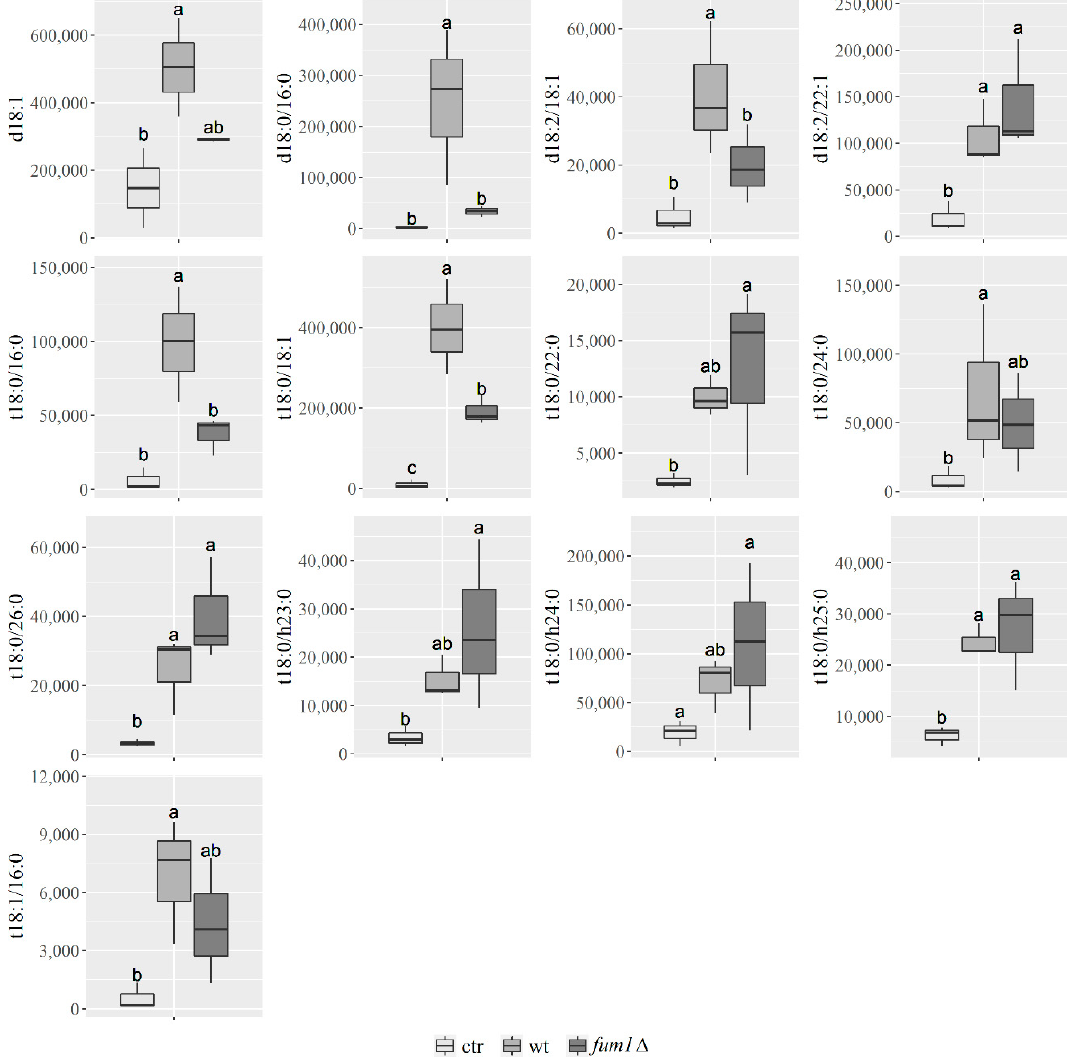
Figure 5. The relative abundance of different sphingolipids at 14 dai. Y-axis: relative abundance of compounds found in maize kernel mock-infected (ctr) and infected with F. verticillioides wild-type (wt) or fumonisin non-producing mutant fum1 ∆ , measured as normalized peak intensity. Box plot represents the distribution of the relative quantity of sphingolipids deriving from three independent replicates which were technically repeated in triplicate. Asterisks indicate statistically significant differences between infected-maize (wild-type or fum1 ∆ ) and ctr at each time point. Significance ( p ≤ 0.05) was assessed by one-way ANOVA followed by Tukey’s test.